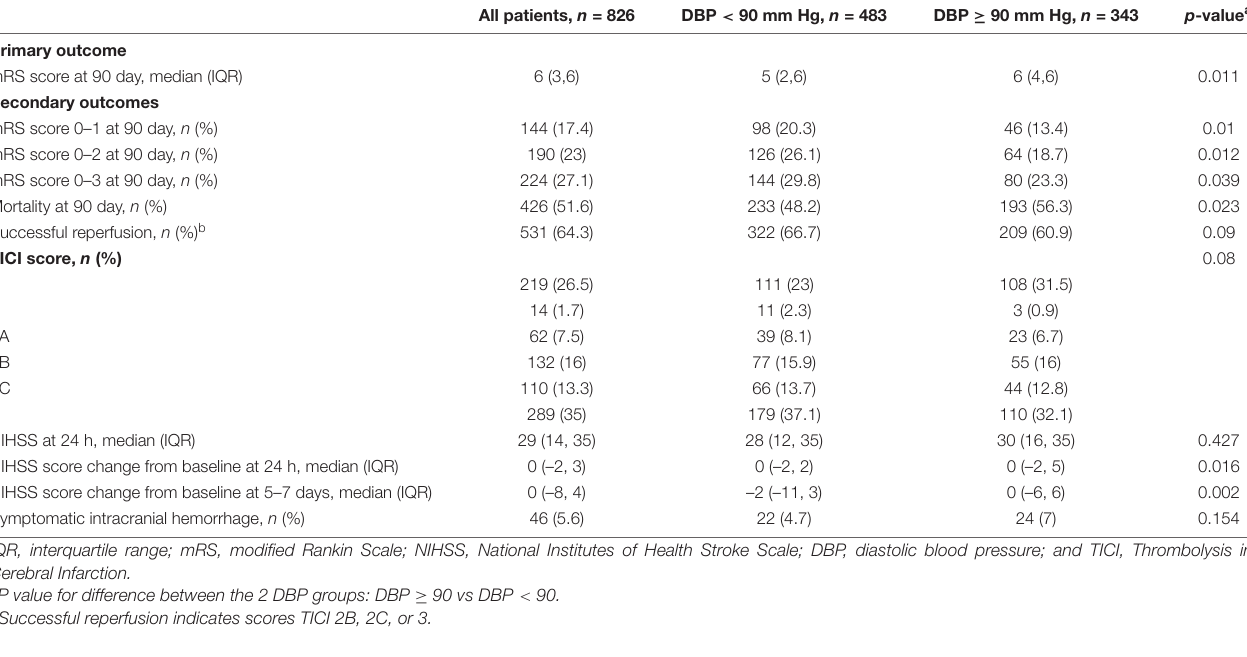
TABLE 5 | Outcomes according to admission diastolic blood pressure.